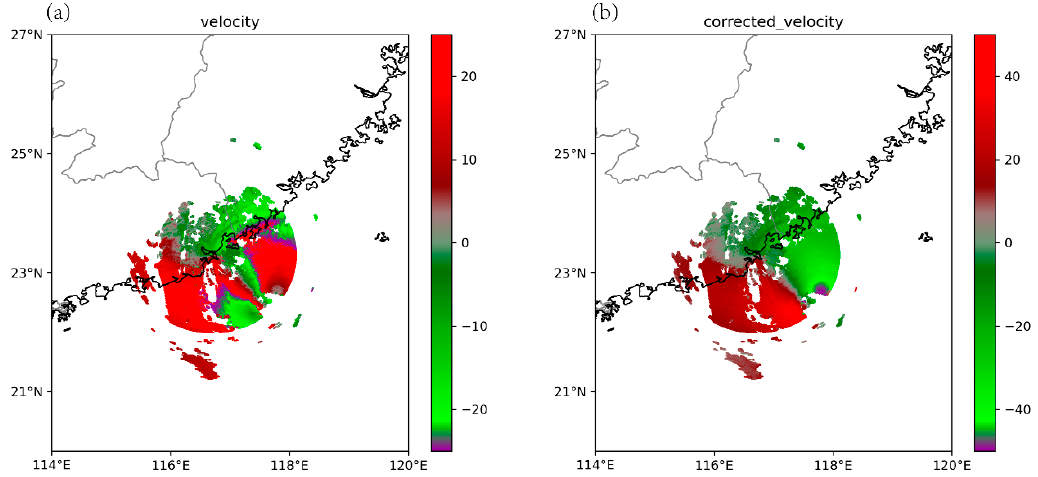
Figure 1. Comparison of the radial velocity (unit: m s − 1 ) from the Shantou Doppler radar (STRD) ( a ) before and ( b ) after the quality control at 1800 UTC on 8 July 2015.